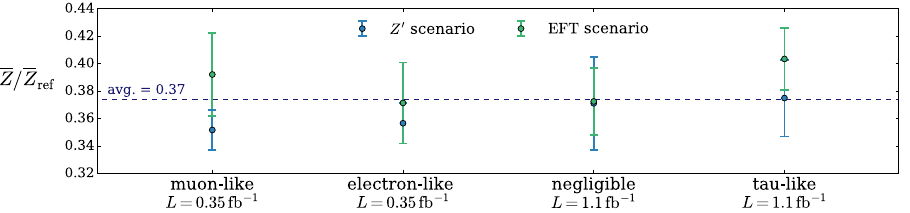
Fig. 25 Summary of the sensitivity of our method, relative to the sensitivity of dedicated model-dependent searches, to selected New Physics benchmark models. The relative performances depend neither on the New Physics model nor on the assumed scenario for systematic